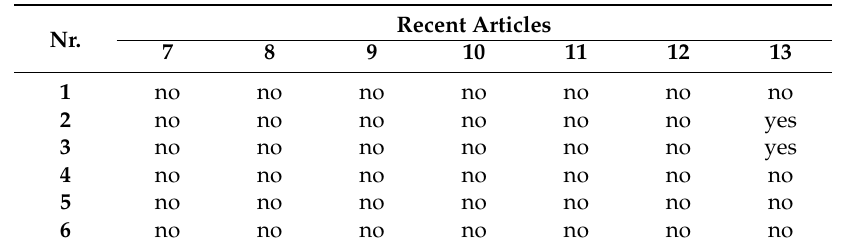
Table 5. Extent to which recent articles which have investigated using steel wool for water treatment were considered by academic journal papers since 2010 (Nr. 1 through 6, Table 2). It is evident that existing articles are typically independent work as just one ancient article was cited by two of the six articles since 2010. Additionally, none of the pioneering work (Nr. 15 and 16) was considered by all articles of the Fe 0 remediation technology